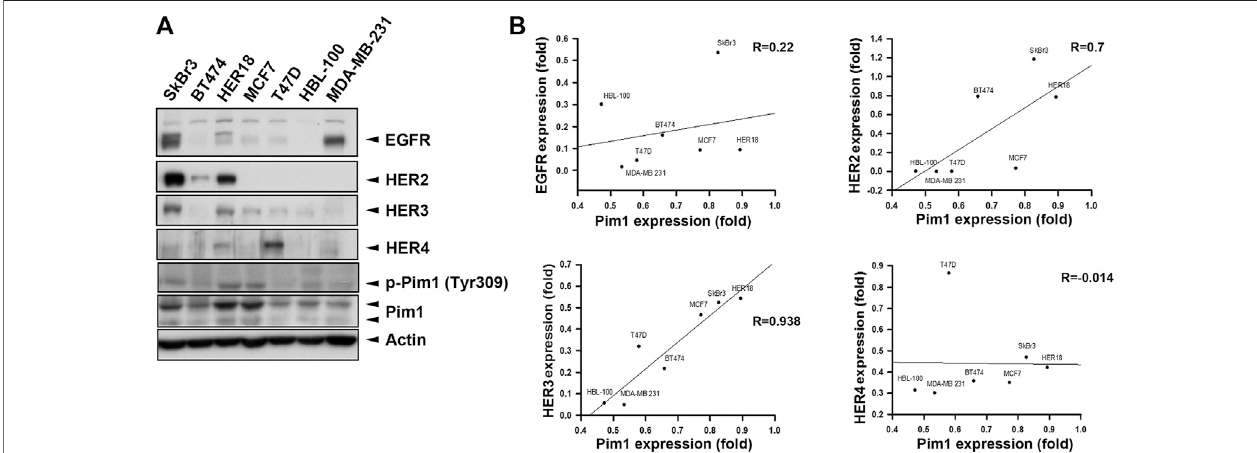
FIGURE 1 | HER2 expression was strongly associated with the Pim1 expression in breast cancer cells. (A) Whole cell lysates of breast cancer cells, including SkBr3, BT474, HER18, MCF7, T47D, HBL-100, and MDA-MB-231 cells, were subjected to protein expression analysis in western blot using the indicated antibodies. (B) The correlations of Pim1 expression with EGFR, HER2, HER3, and HER4 expression were analyzed by regression analysis based on the results shown in (A)